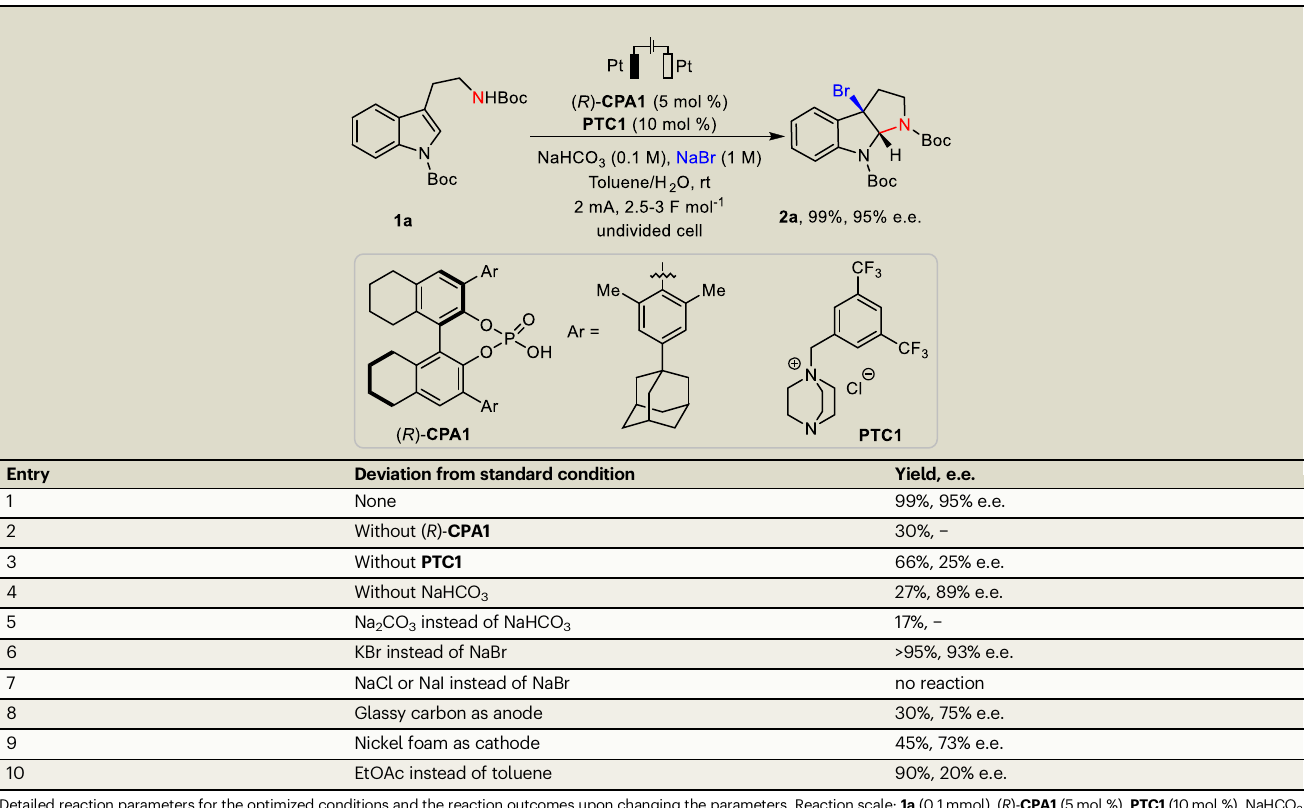
Table 1 | Reaction condition optimization